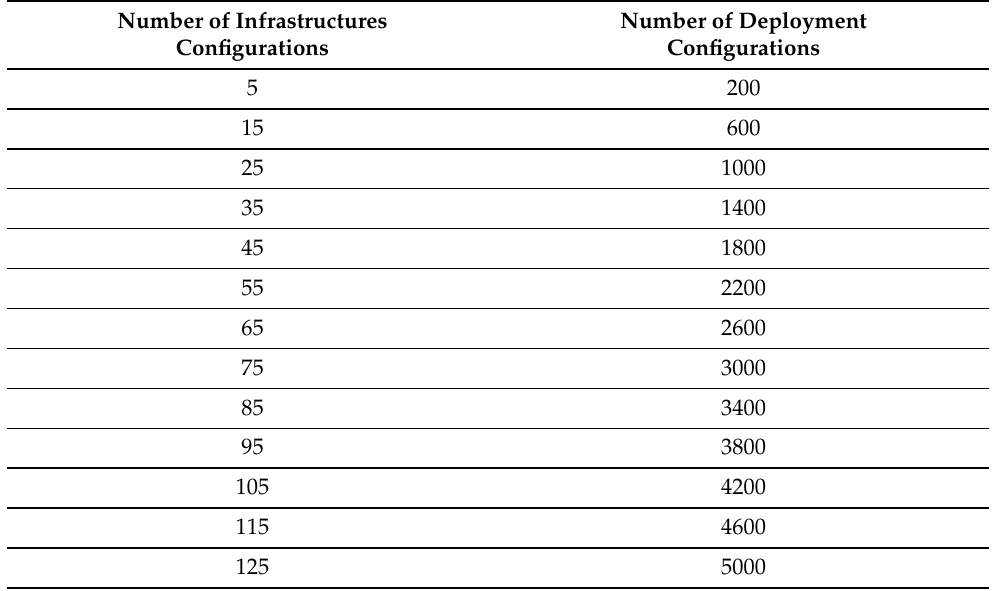
Table 2. Variation in the model complexity when comparing the number of submitted infrastruc- ture configurations.